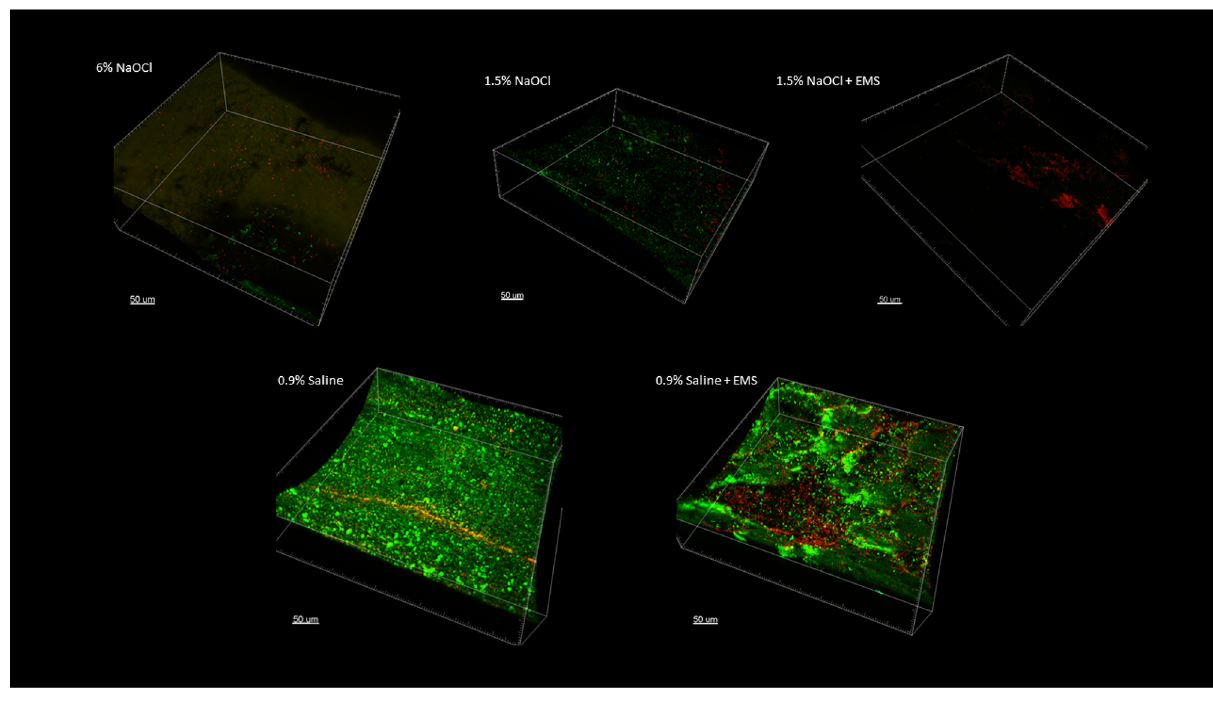
Figure 6. Apical 1.0–1.5 mm confocal images.